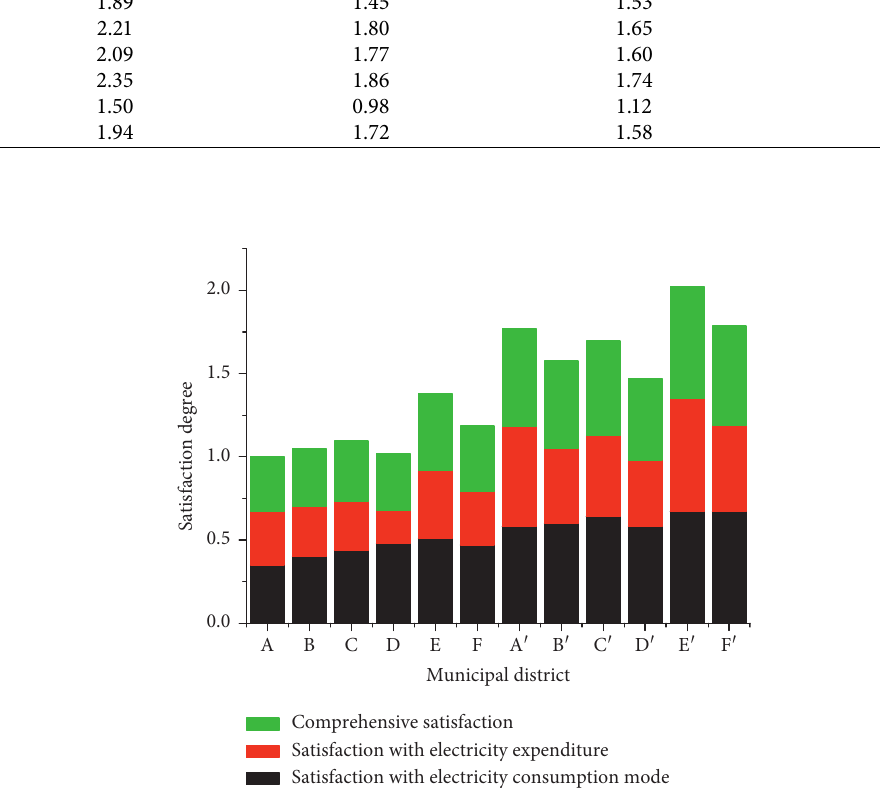
Figure 9: User satisfactions before and after optimization. A to E represent satisfaction before optimization and A ′ to E ′ represent satisfaction after